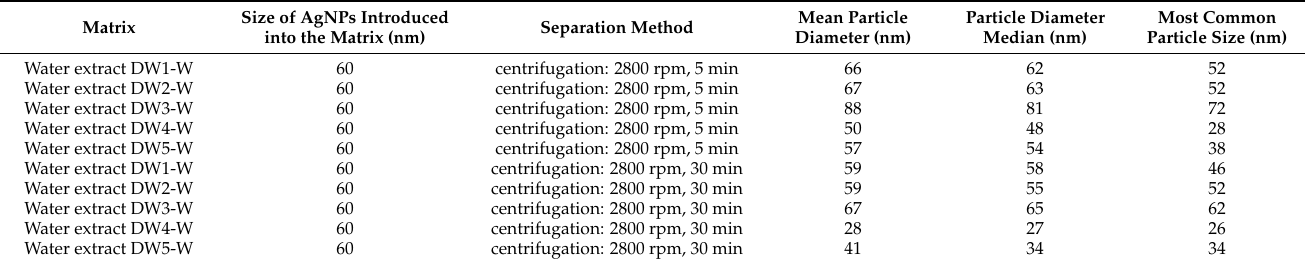
Table 5. Verification of the effect of centrifugation time at 2800 rpm on the separation efficiency of silver nanoparticles for DW(1-5)-W drilling waste water extract samples with AgNPs (60 nm). The table contains values obtained for the mean particle diameter, particle diameter median, and most common particle size.